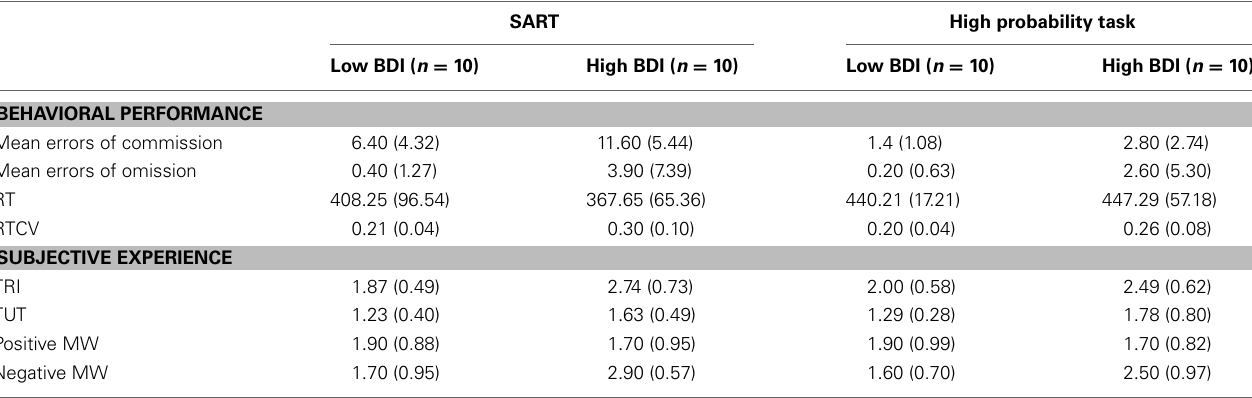
Table 4 | Behavioral performance and subjective experience data for participants in the high and low BDI groups.